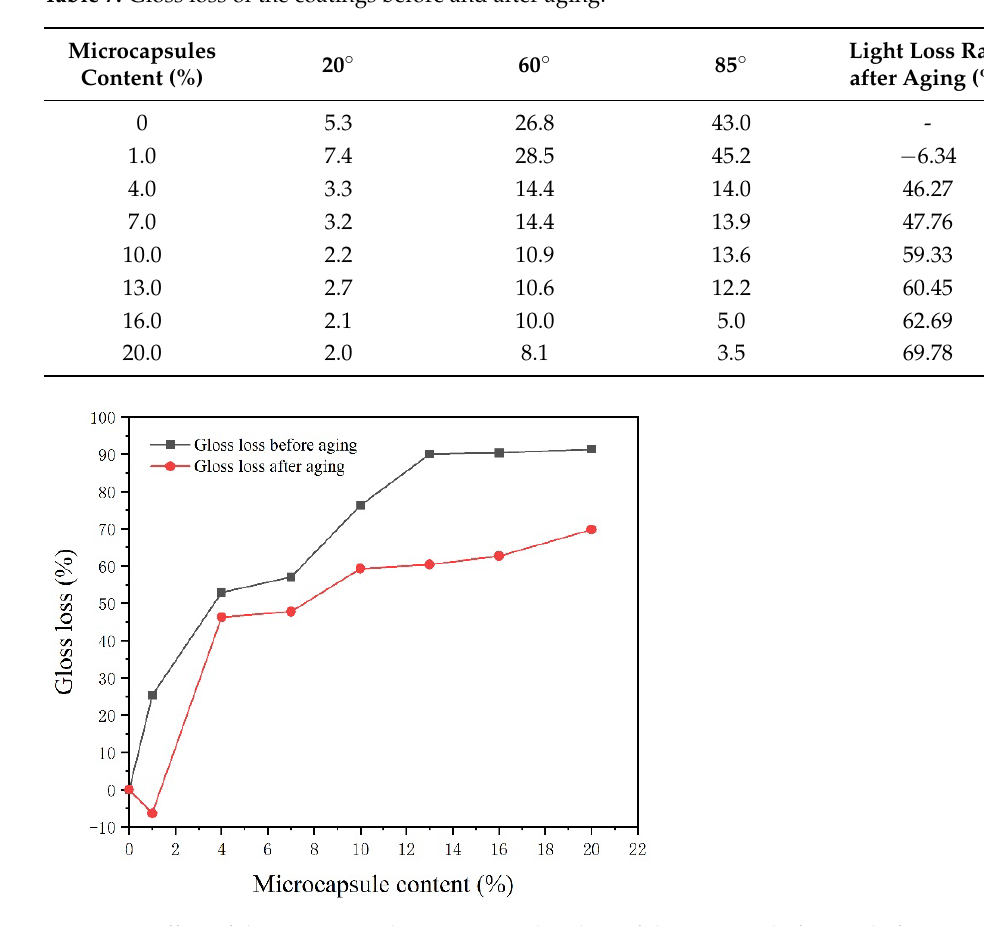
Table 7. Gloss loss of the coatings before and after aging.